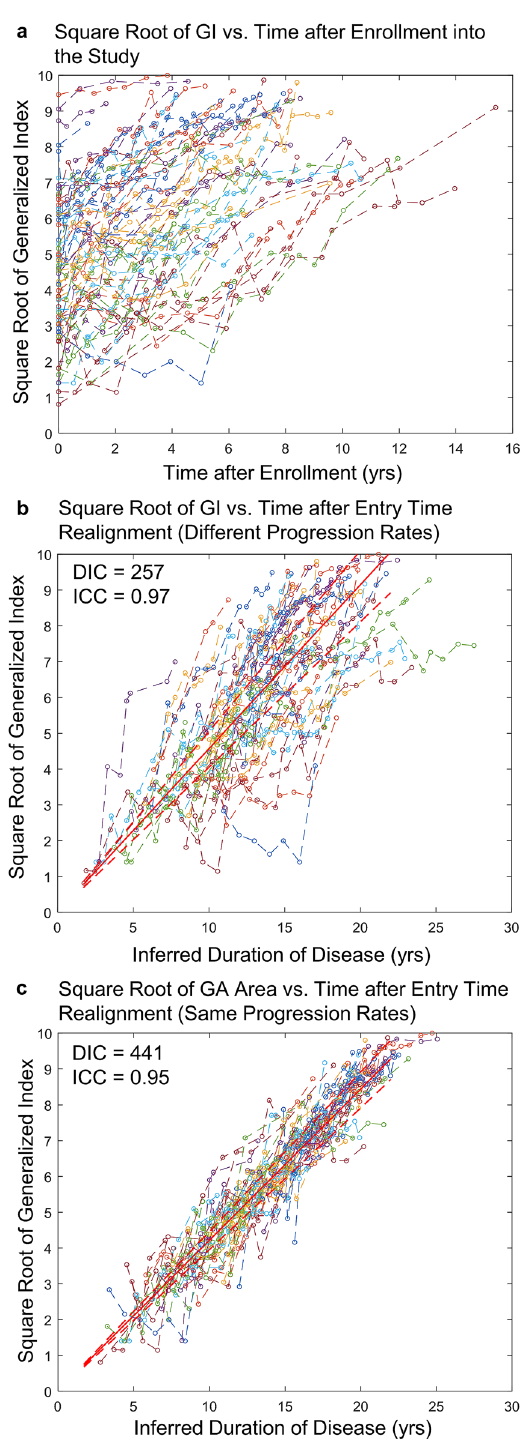
Figure 6. The square root of the generalized index (GI) as a function of time in 71 patients with untreated Huntington’s disease. ( a ) Raw datasets collected in the study. The plot shows a series of lines for GI progression in untreated patients with Huntington’s disease after enrollment into the study. Note that the initial GI varied widely among individual patients, suggesting that different patients had different durations of diseases at baseline; the variation in the slopes seen visually suggest there were different progression rates as well. ( b ) Square root of GI as a function of time after inferred duration of disease, which was estimated from the Bayesian entry time realignment method (BETR). In this model, the square root of GI increases linearly over time and different datasets were fit with different trend lines. The red solid line and the dashed red lines represent the mean and 95% confidence interval of the square root of GA area at each time point. ( c ) Square root of GI as a function of time after inferred duration of disease, which was estimated from BETR. In this model, all datasets were fit with the same trend line, which helpful to visualize the overall trend. ICC = intraclass correlation